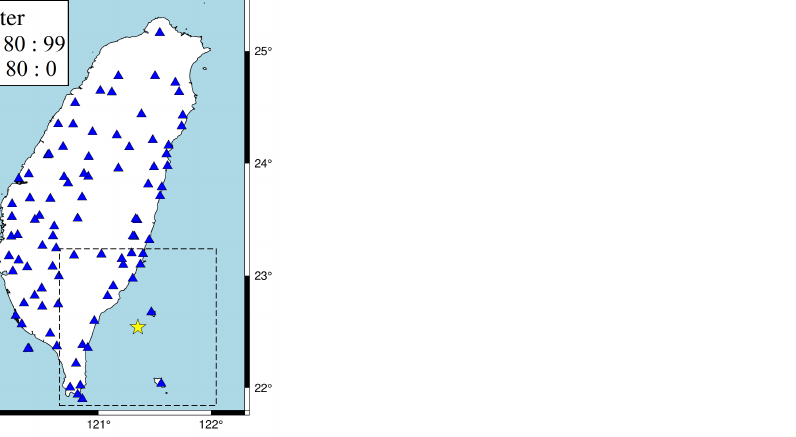
Figure 9. 17 January 2021 Taitung earthquake ( M L = 5.5, depth = 21.1 km). The dotted box is the area close to the hypocenter and chosen to be investigated in Figure